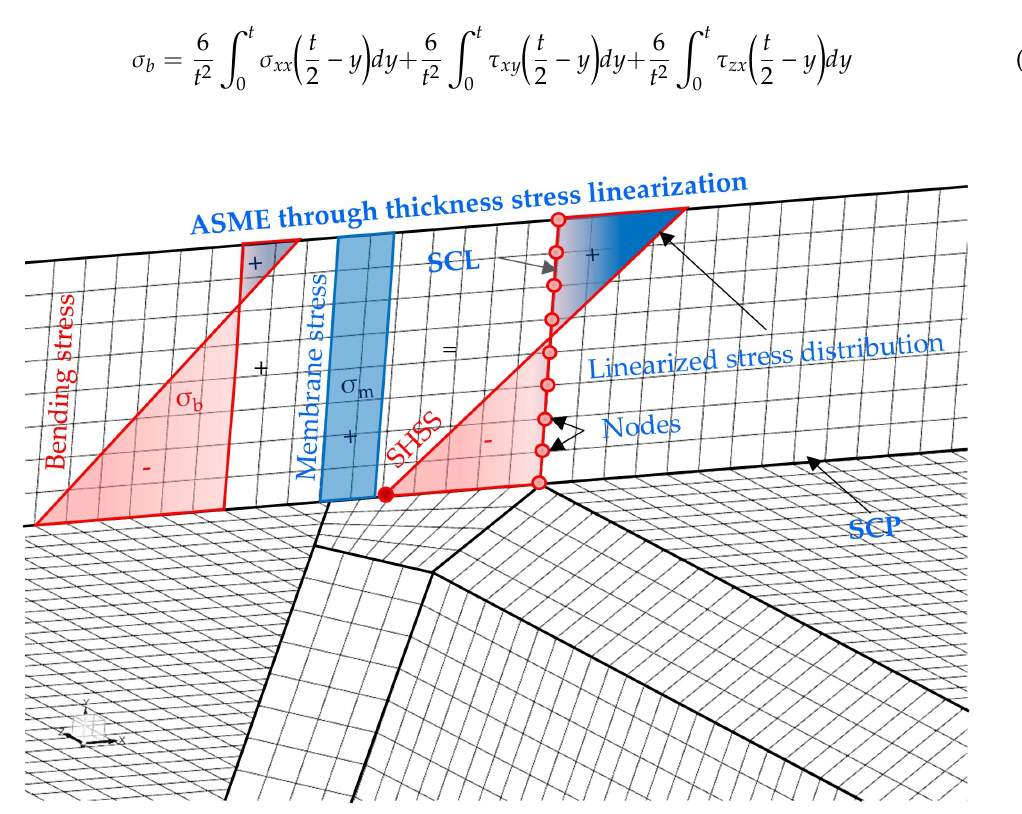
Figure 3. American Society of Mechanical Engineers (ASME) through thickness stress linearization (TTSL) method for evaluation of SHSS at the weld-toe with 2.0 mm CHEXA20